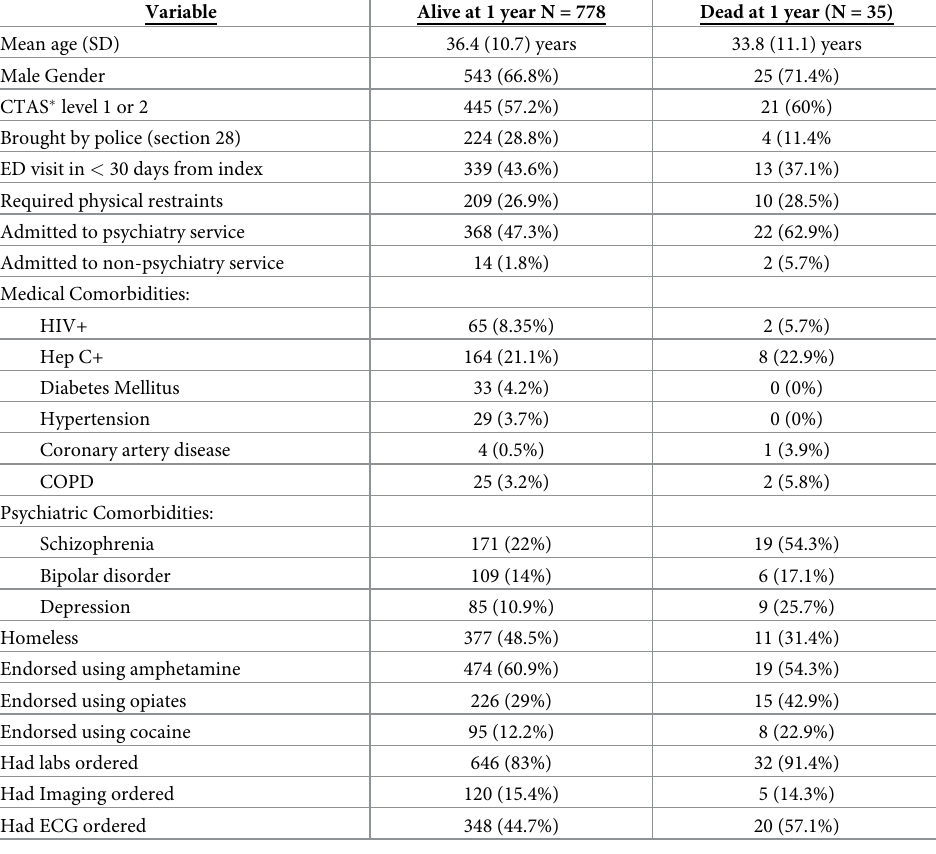
Table 1. Index visit demographic data for patients alive versus dead at 1 year post index